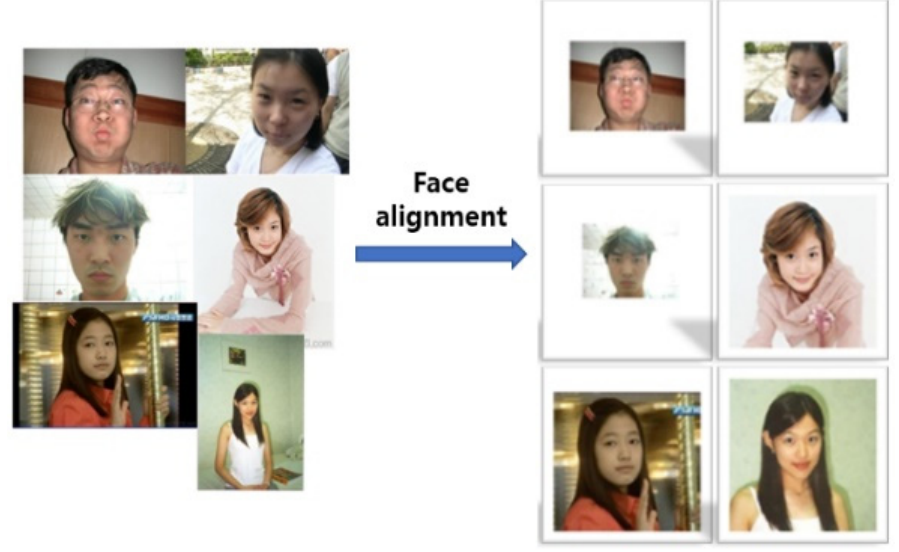
Figure 1. Images normalized by face alignment.